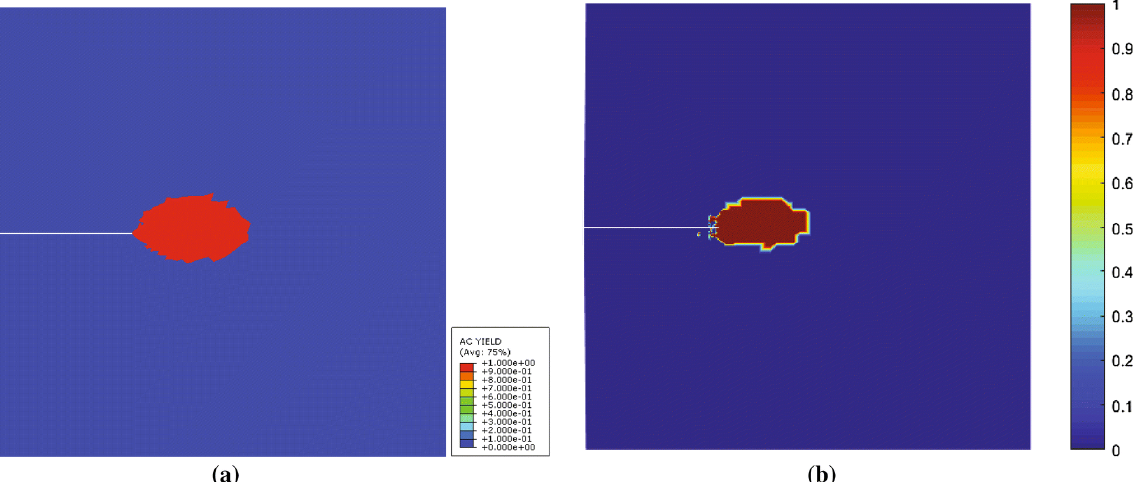
Figure 13. The plastic zone simulated by CZM with Drucker–Prager yield criterion. Reprinted with permission from Ref. [233]. Copyright 2018, Elsevier.